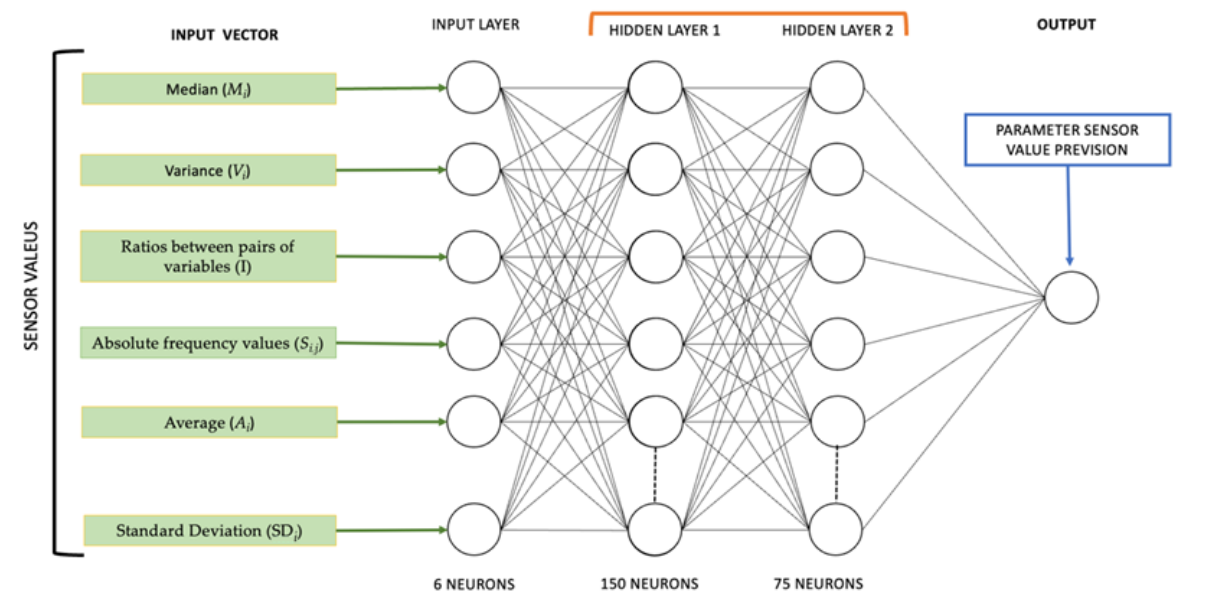
Figure 3. Architecture of the artificial neural network.